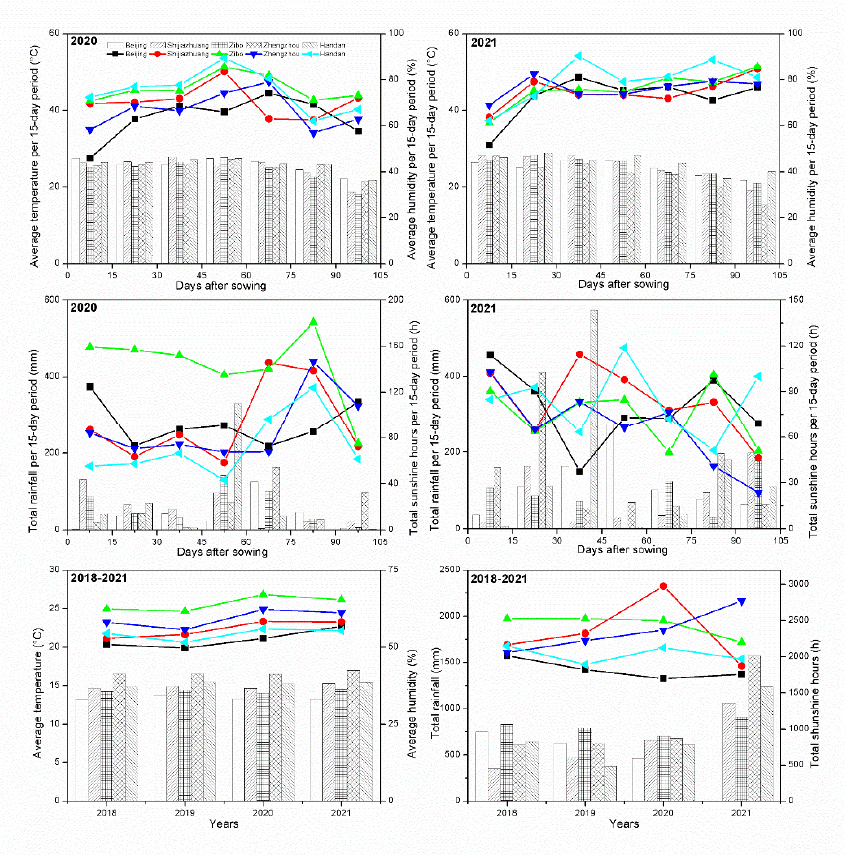
Figure 2. Air temperature (vertical bars), rainfall (vertical bars), sunshine hours (scatter and line), and humidity (scatter and line) in five sites in 2018–2021.